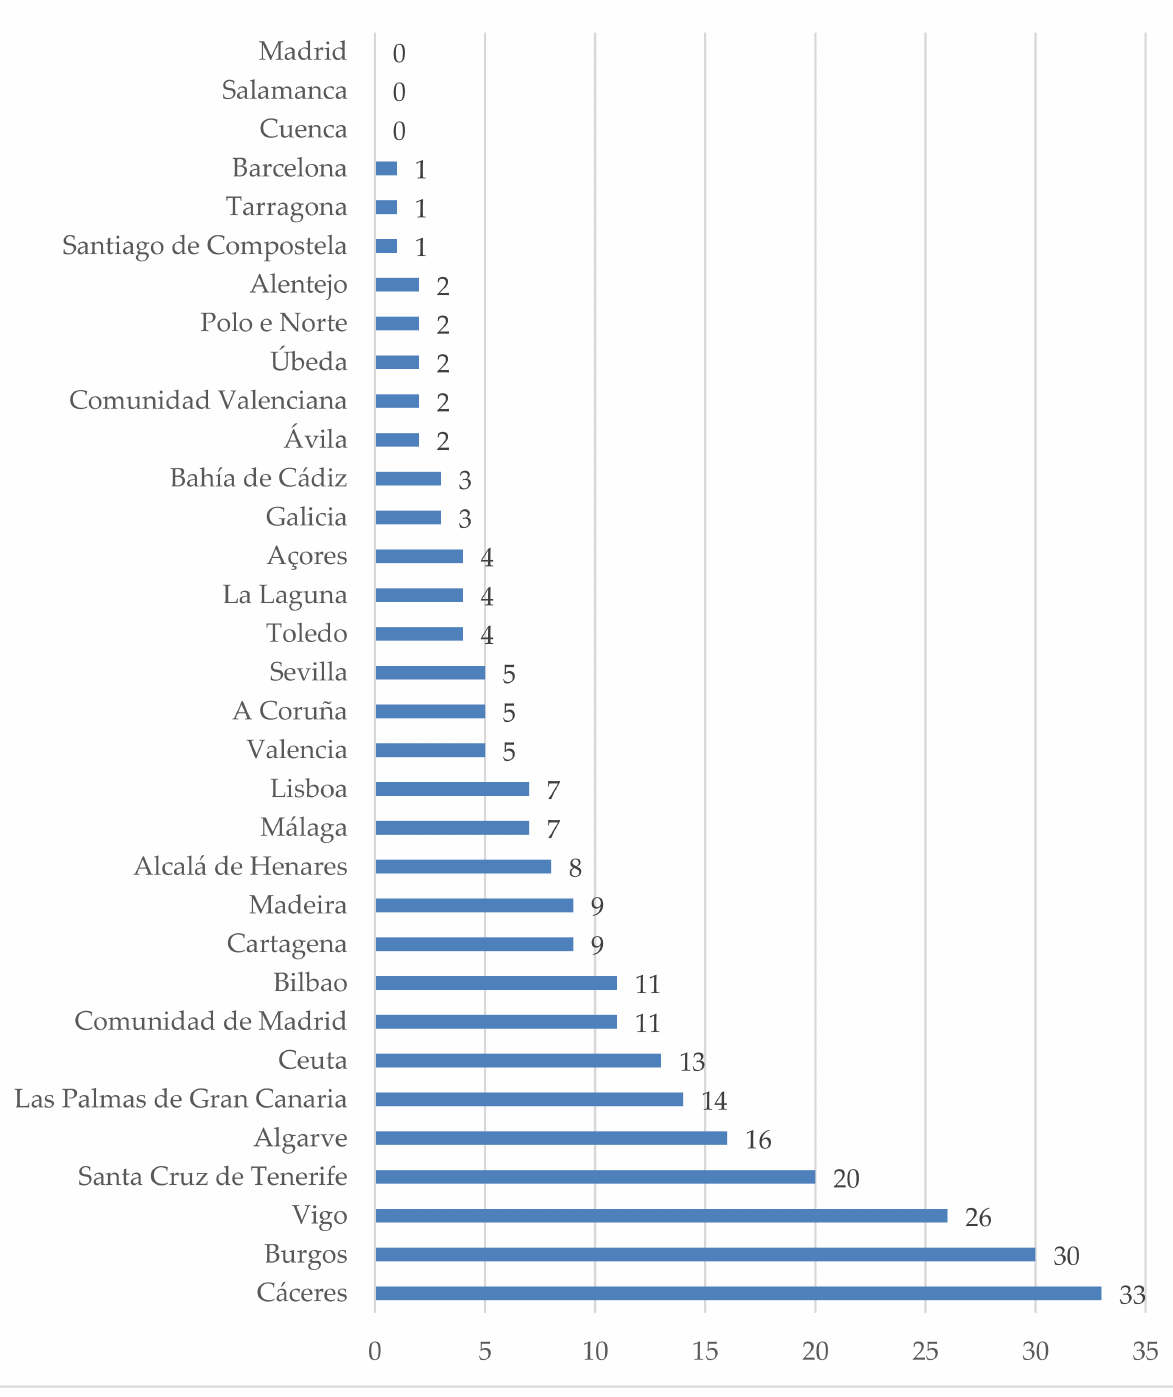
Figure 11. Total analyzed mobile app accessibility failures. Source: own elaboration from Google ´ s Accessibility Scan- ner